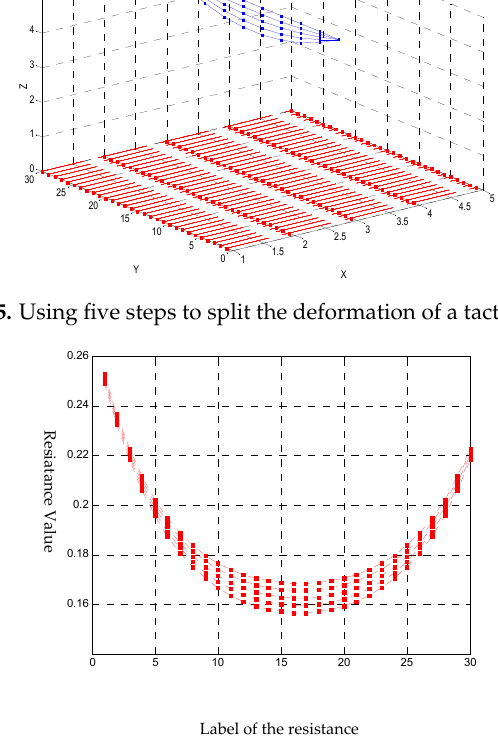
Figure 6. The corresponding 30 resistance signals of each step (five steps).